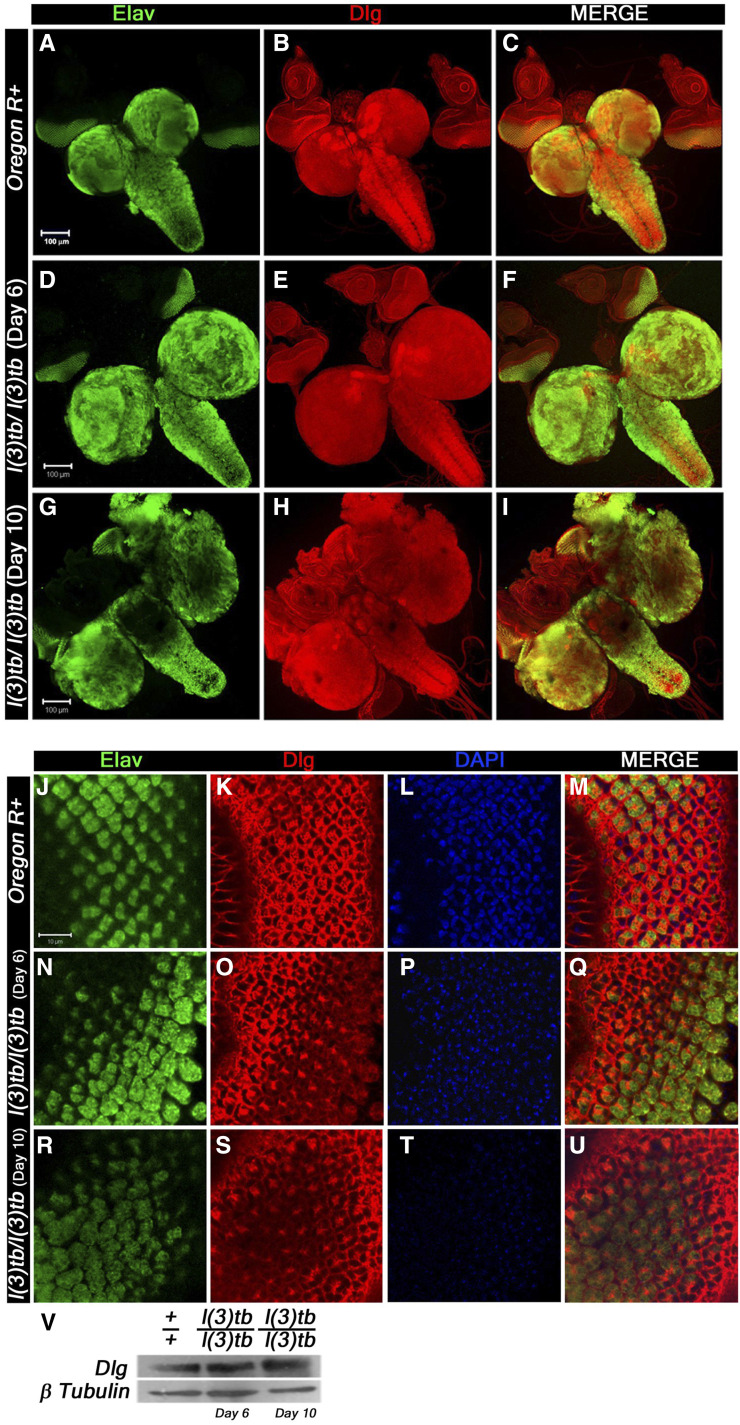
l(3)tb mutants show progressive loss of mature neurons along with increase in junction proteins. Confocal photomicrograph show loss of mature neurons and increase in junction protein, Dlg, in delayed (Day 10) homozygous l(3)tb. 3rd instar larval brain shows intense staining of Elav (green) in day 6 (D) of homozygous mutant later on show loss of staining in enlarged brain of day 10 (G), while the wild type brain (A) showed normal pattern of Elav staining. Dlg stained the ventral nerve chord and central brain in optic lobes of wild type (B), which is similar to that observed in day 6 of homozygous mutant brain (E) but in delayed larval brain, (day 10), the pattern was altered (H). Scale shown is 100µm. Neuronal tissue from eye imaginal discs also display loss of neurons seen through Elav staining in day 10 (R) as compared to day 6 (N) in homozygous l(3)tb mutant as well as to wild type (J). Pattern of junctional protein, Dlg, in eye imaginal discs is also altered in day 10 (S, V) as compared to day 6 (O) and wild type (K). Counter stain with DAPI shows very weak intensity in day 10 (T) reflecting disintegrating chromatin as compared to day 6 (P) and wild type (L). Scale bar represents 10 µm.